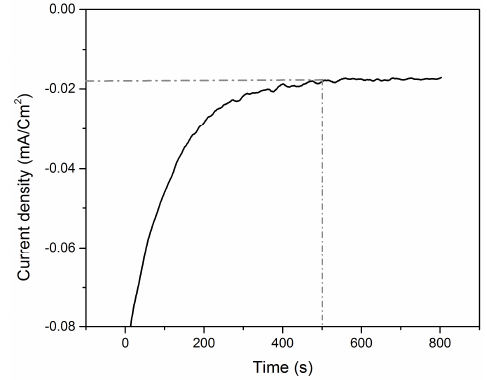
Figure 4. Chronoamperometric curve of the galvanic replacement of Te by Pt at open circuit voltage (OCV).